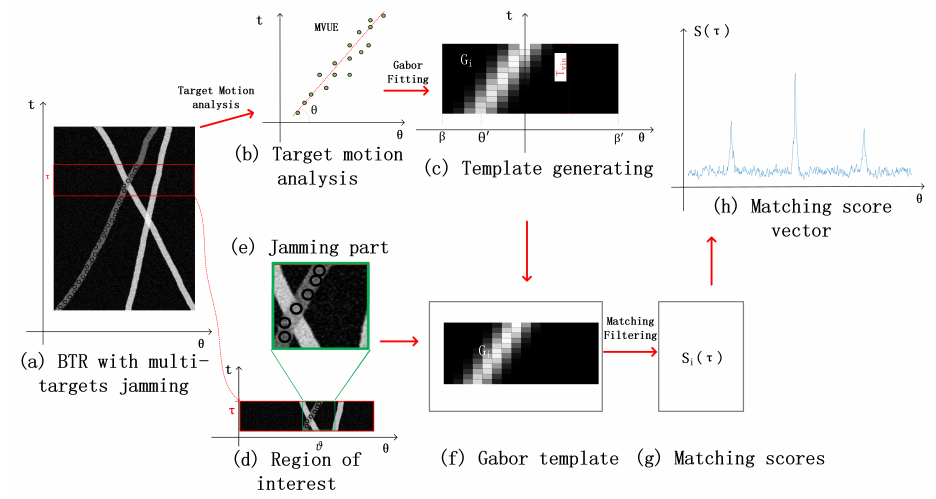
Figure 2. Frame of the proposed method after